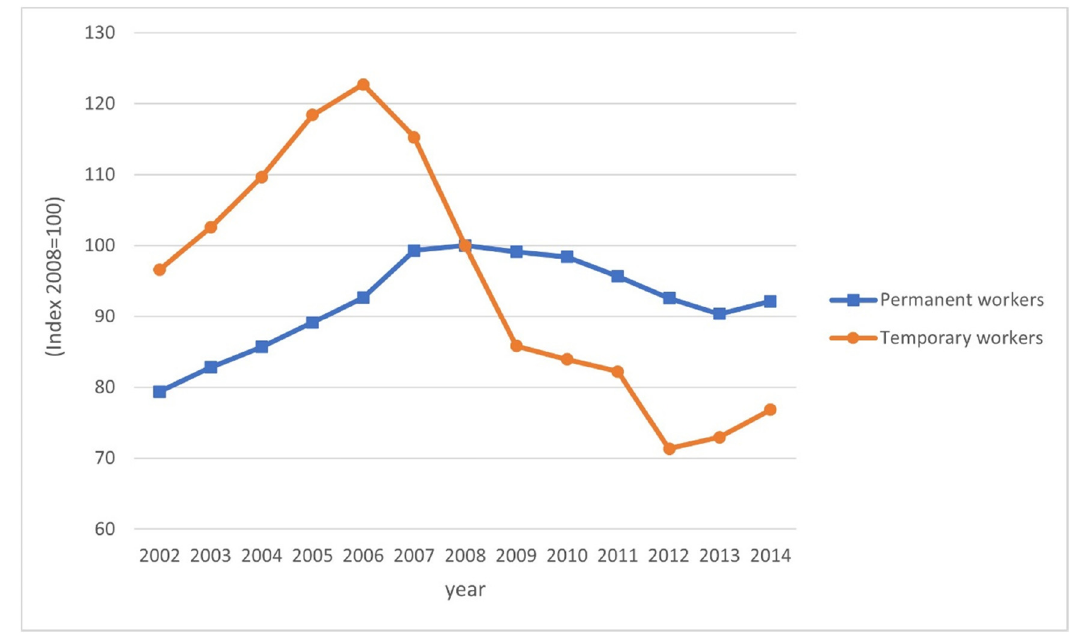
Figure 4: Permanent and Temporary workers in Spain. Source: Instituto Nacional de Estadística ( INE )